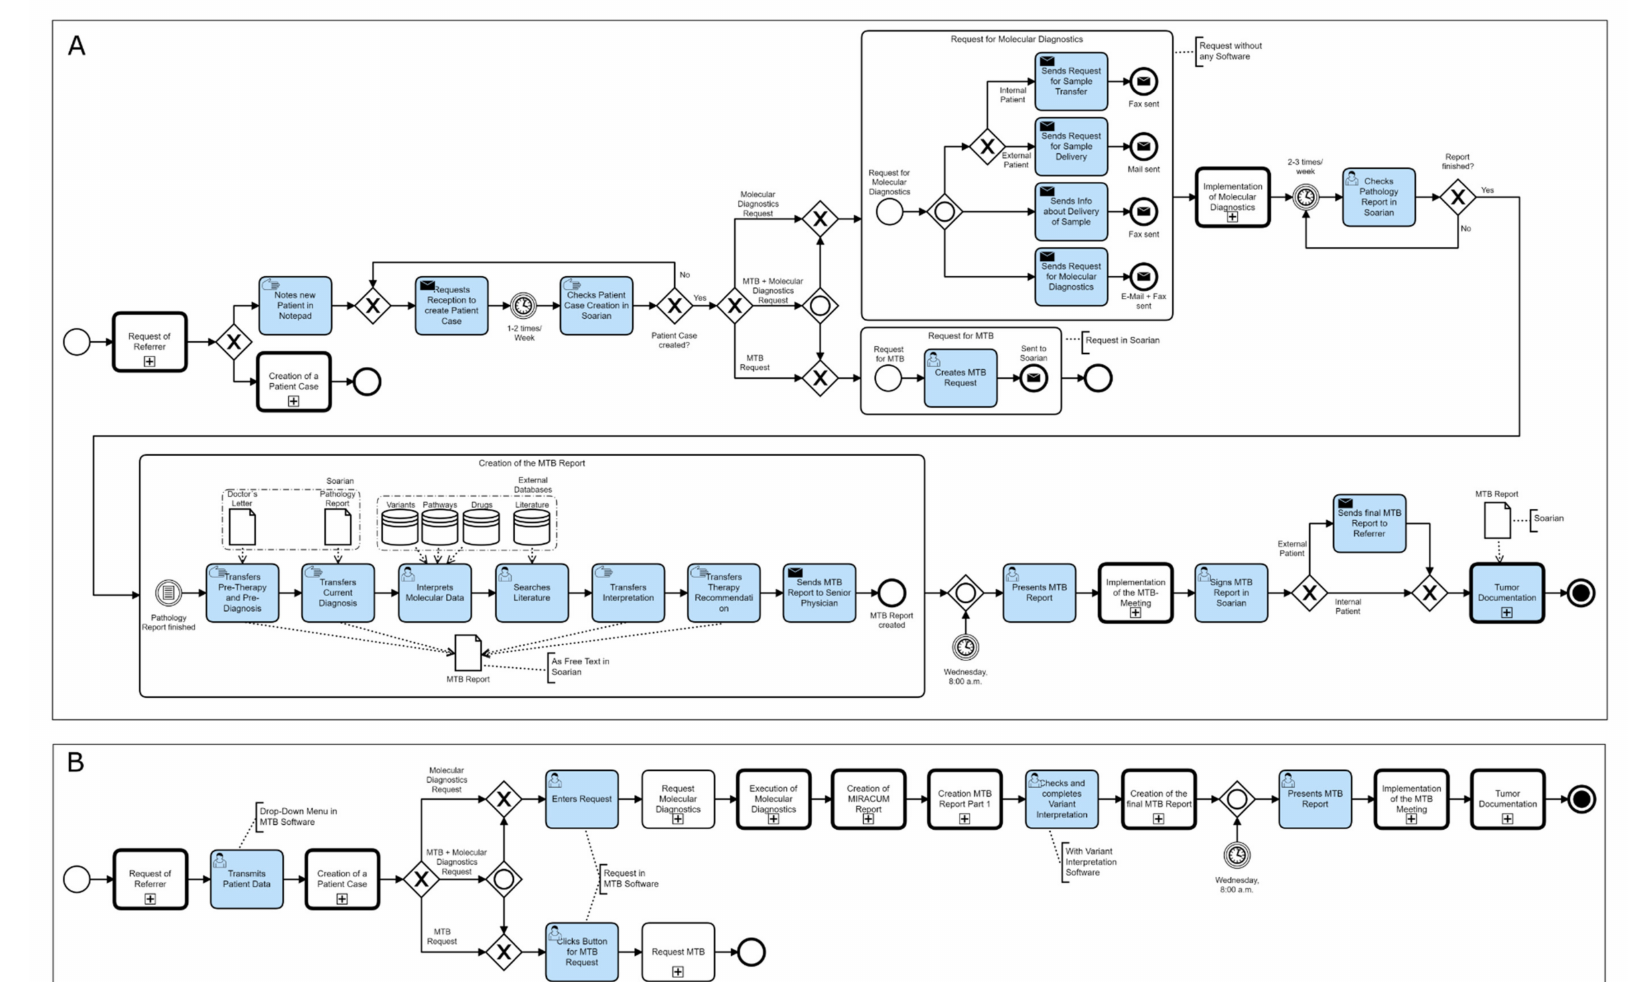
Figure 2. The Process of a Molecular Tumor Board from the physician’s perspective in the current ( A ) and optimized ( B ) form at the University Cancer Center Hamburg (UCCH). The tasks performed by the physician, in blue, show a significant workload